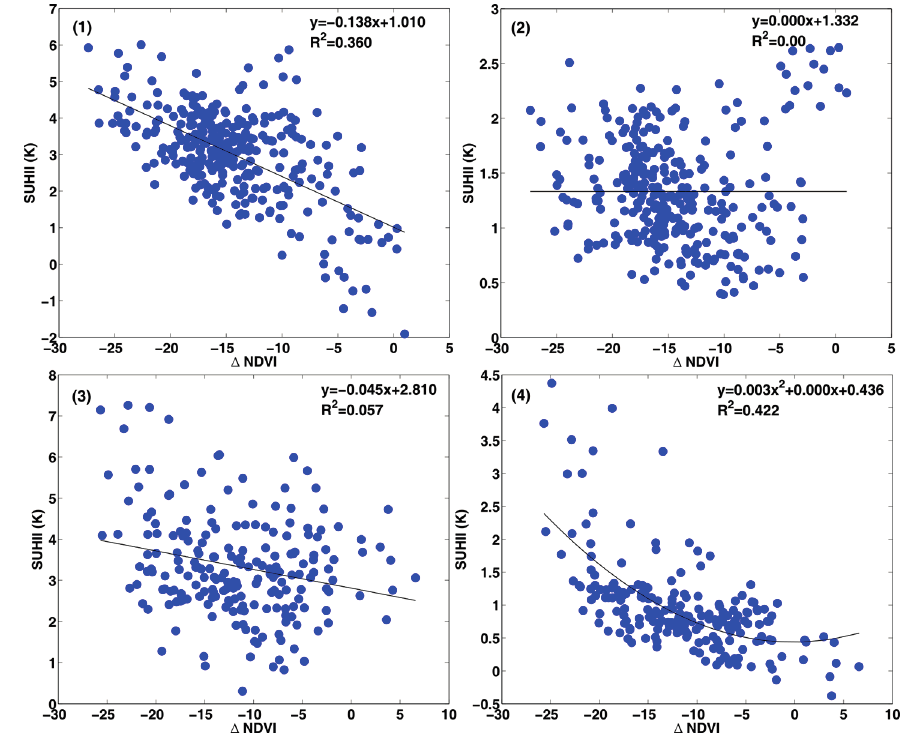
Figure 6. Relationship between summer SUHII and Δ NDVI for: ( 1 ) daytime SUHII in northern China; ( 2 ) daytime SUHII in southern China; ( 3 ) nighttime SUHII in northern China; and ( 4 ) nighttime SUHII in southern